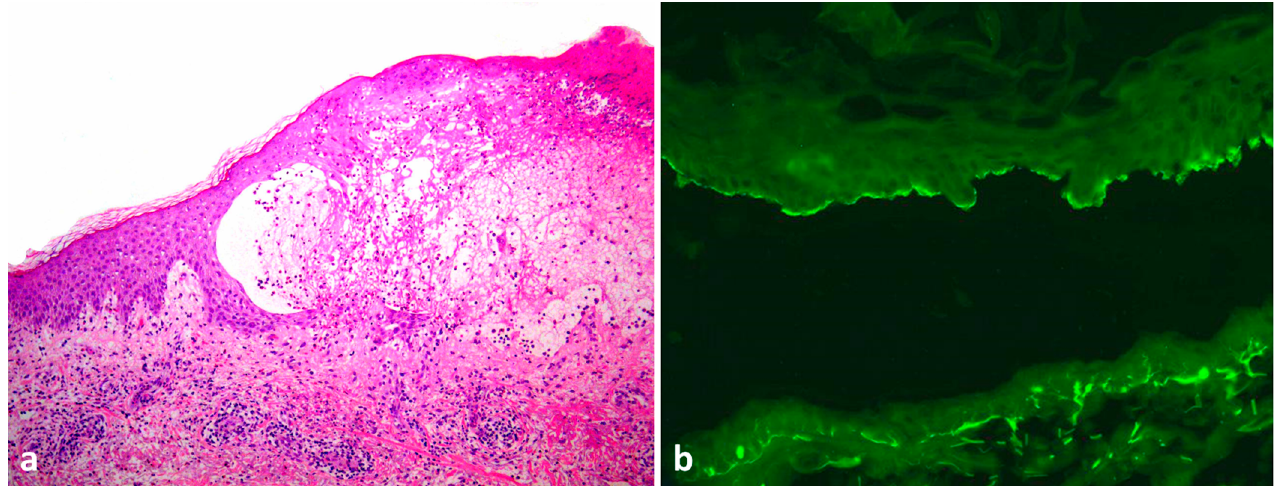
Figure 2. Punch biopsy of the lesion revealing a subepidermal blister containing fibrin, eosinophils and mononuclear cells, consistent with bullous pemphigoid ( a ). Direct immunofluorescence on salt-split skin reveals IgG on the epidermal side of split skin (blister roof) ( b ).